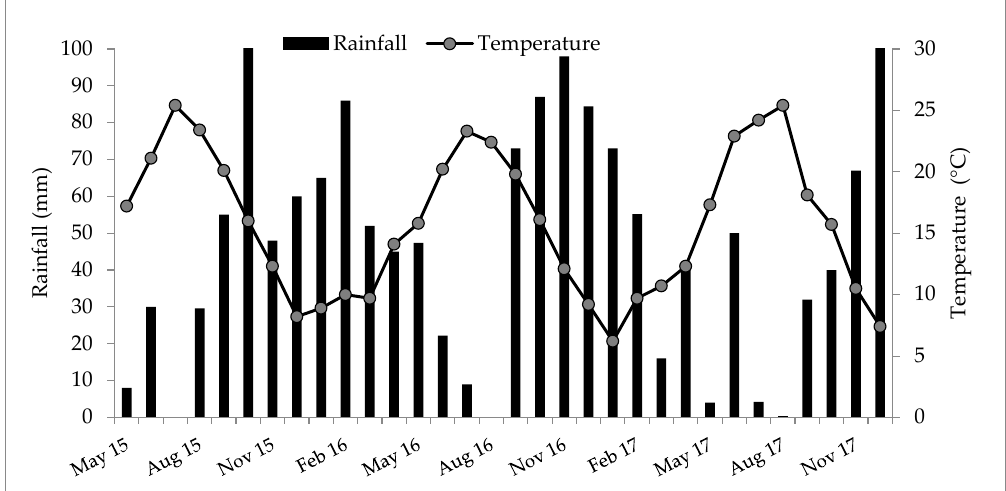
Figure 2. Monthly rainfall and mean temperature at the northern Sardinia site during the study period.